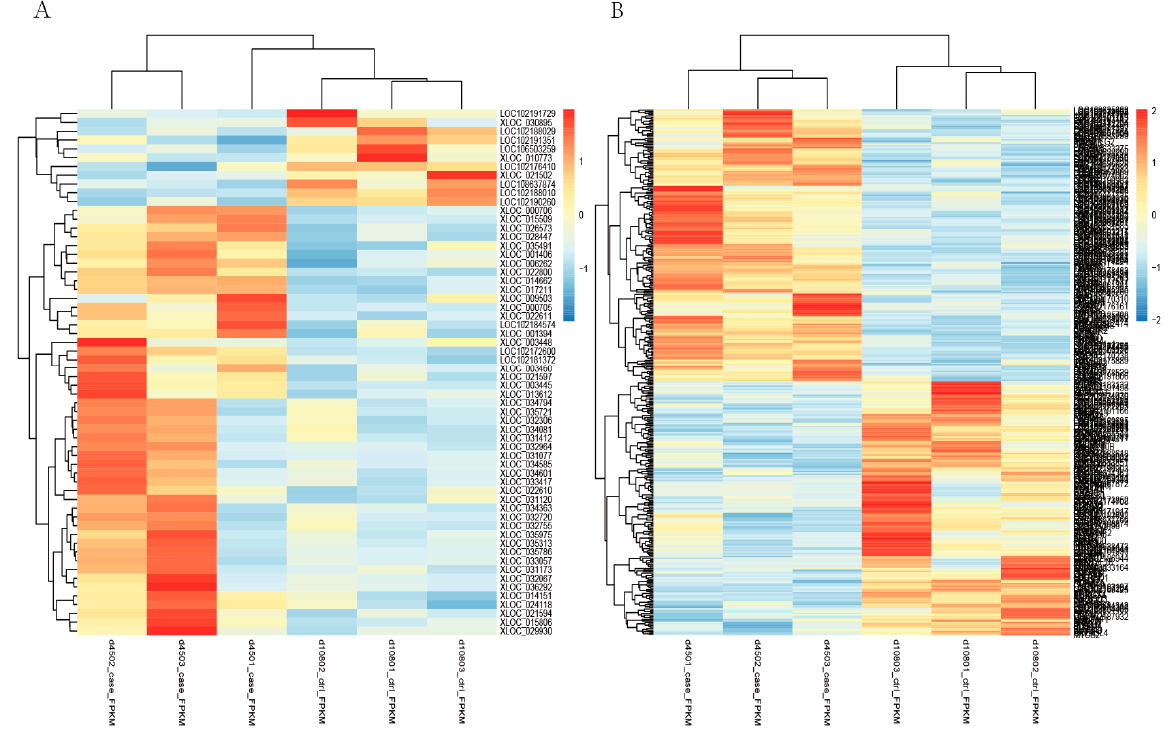
Figure 5. Cluster analysis of differentially expressed mRNAs and lncRNAs from the goat skin samples at different stages (day 45 and day 108): ( A ) the cluster analysis of FPKM values of 60 differentially expressed lncRNAs; ( B ) the cluster analysis of FPKM values of 352 differentially expressed mRNAs. Note: The color of the heat map represents the level of gene expression. The horizontal axis represents the clustering results of different samples and samples, and the vertical axis represents the gene name and the clustering results of